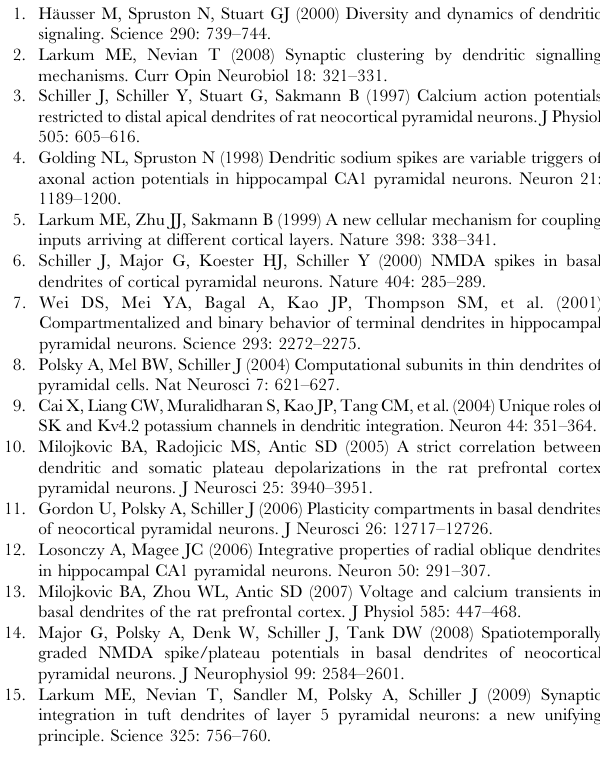
Figure S2 Re-quantification of the invariability of the bumps. The invariability of the bumps were quantified by the times for the 60 % reduction of the initial values. A , B , C and D correspond to the Figures 2D, 3B, 4B and S3A, respectively. Figure S3 Simulation runs with a small value of EPSP. Simulations with the EPSP size 7 : 5 time smaller than that used in Figure 3. The time constant of dendritic dynamics is set to t d ~ 200 ms. (A) The decay time constant obtained by the exponential fitting of the inner products is shown in B . The results look similar to those obtained with the larger value of EPSP (Figure 3). (inset) The clear bump in the network activity is observed at s noise ~ 25 : 7 pA. (B) Inner products of somatic activity patterns for different values of noise intensity, s noise . (C) The clustering of somatic action potentials declines with the increasing noise intensity, s noise . (D) The destruction-corrected degree of immobilization as a product of A and C that are scaled to make those range be unity shows the clear high-value zone, which means that strong noise immobilizes the bump activity without breaking up the bump. Table S1 Summary of the relationship between the observed bump modes and the noise and dendritic